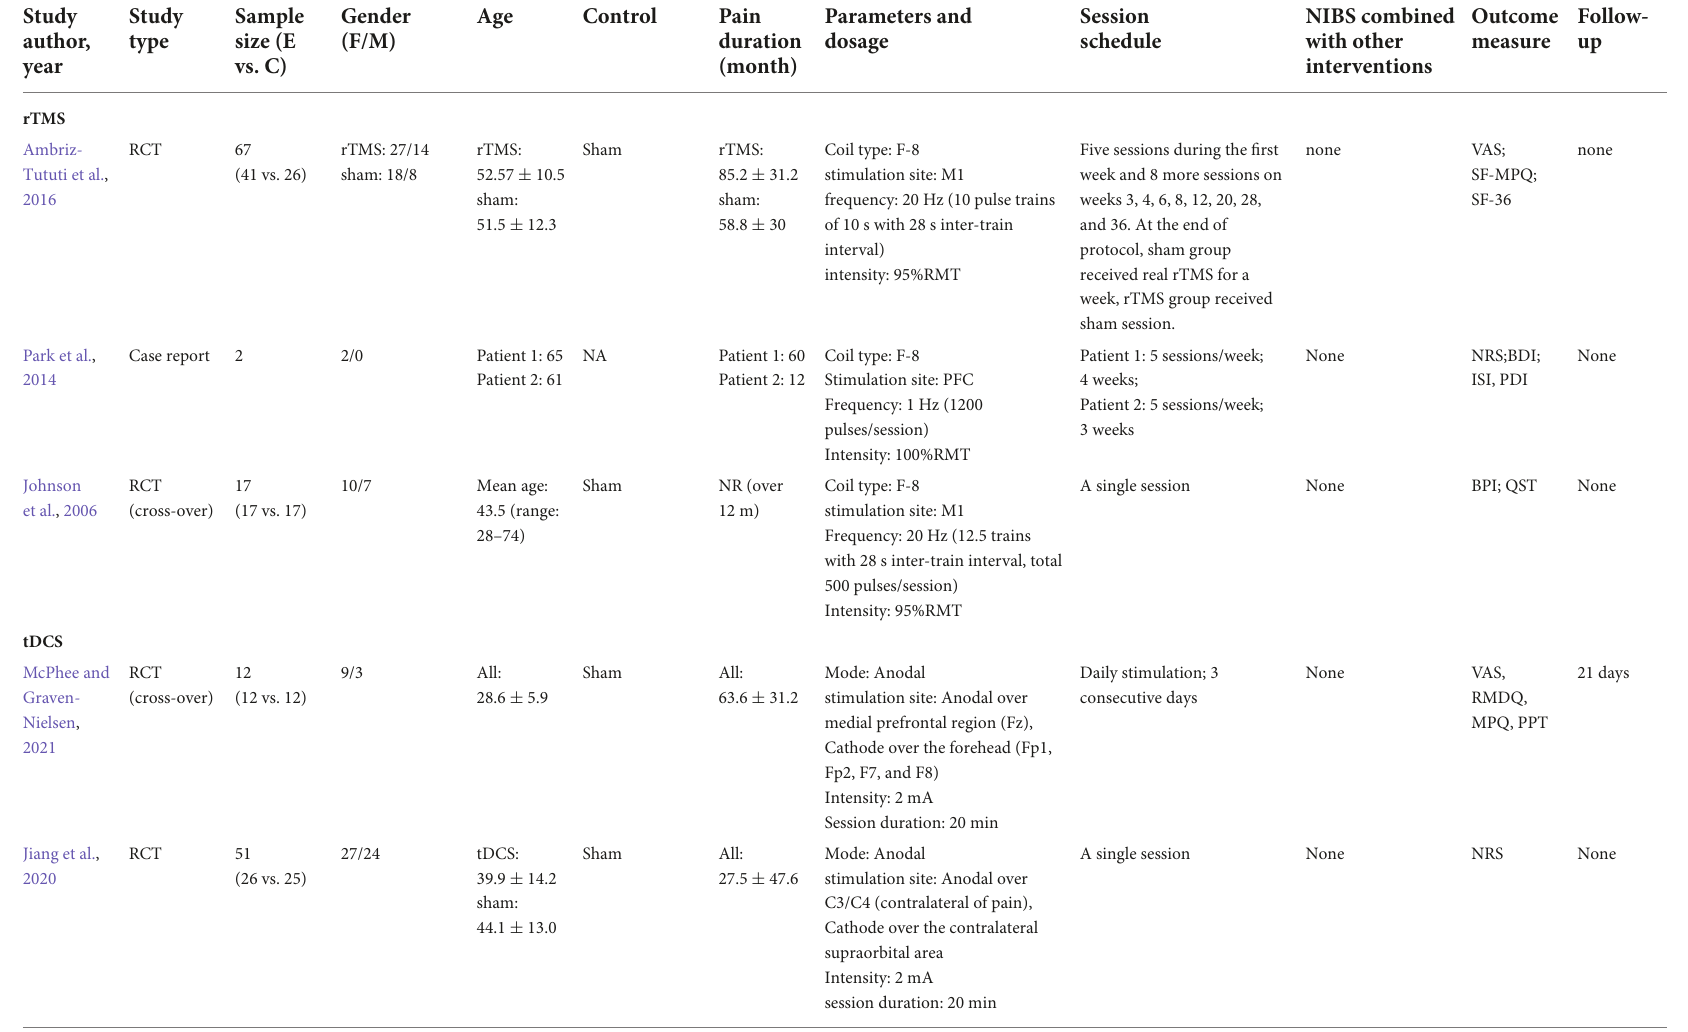
TABLE 1 N on-invasive brain neuromodulation (NIBS) studies for chronic low back